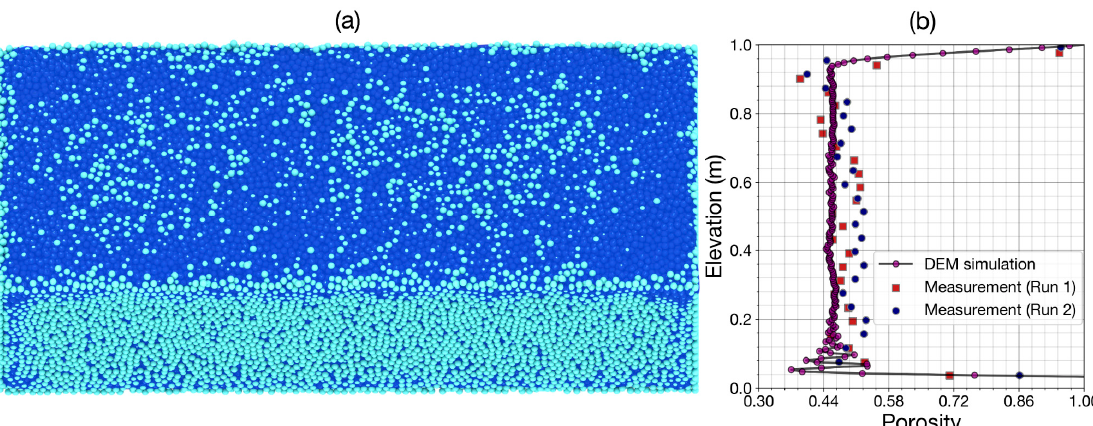
Figure 7. Porosity obtained from DEM simulations in comparison with the porosity measurement of Navaratnam et at. [ 41 ] ( a ) gravel flume, ( b ) vertical porosity variation.